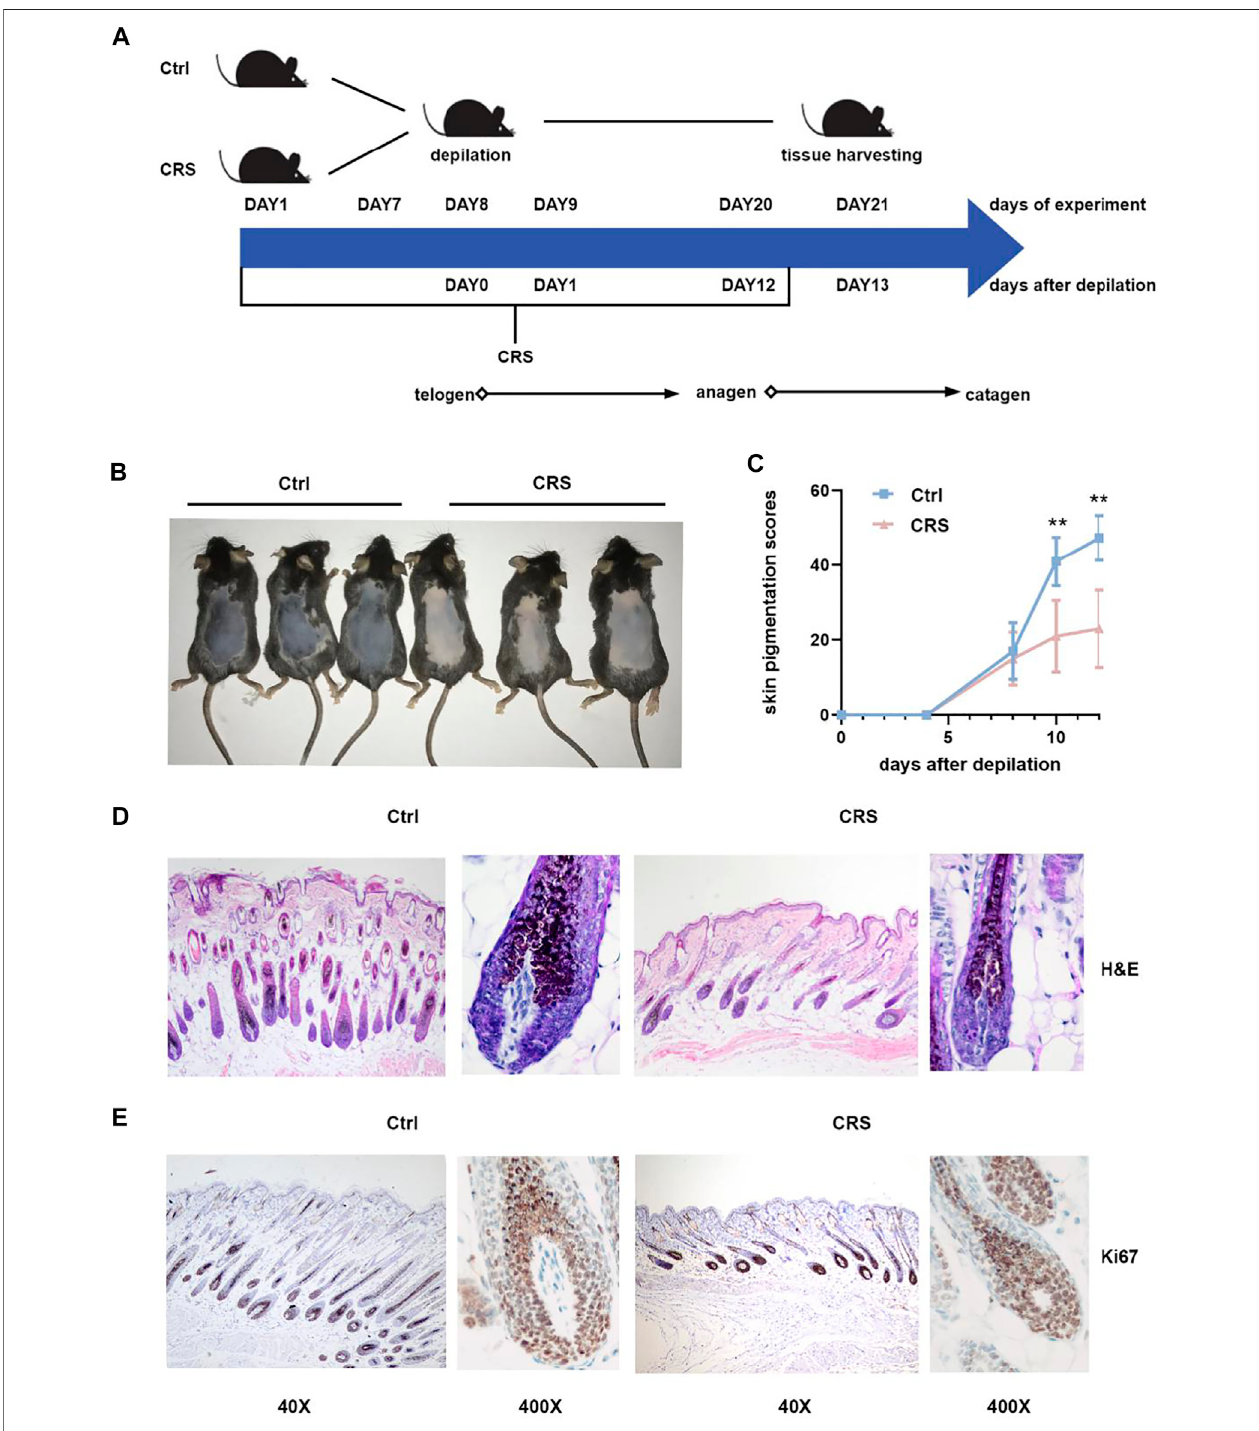
FIGURE 1 | CRS signi fi cantly suppresses hair growth. (A) Flow chart of the animal experiment. The CRS treatment was applied from day1 and lasted for 20 days. Thedepilationofmice wasonday8oftheexperiment, withoutapplyingCRS.Onday21oftheexperiment, allanimals weresacri fi cedforhistologicaland metabolomics and transcriptomics analysis. (B) Photograph shown was taken on day 21 of experiment in (A), by which time mice treated with CRS exhibited hair growth inhibition versus control. (C) Skin melanin pigmentation scores (described in Materials and Methods) of murine dorsal skins treated with CRS versus control. Data are representedasmean±SD.n=5miceineachgroup. p valuesaredeterminedbyStudent ’ st-test.** p < 0.01comparedwithcontrolgroup. (D) H&Estainingshowedthe morphological changes in hair follicle. Magni fi cation: 40×on the left; 400× on the right. (E) Immunohistochemistry for Ki-67 in back skin sections obtained from CRS group and control group. Magni fi cation: 40× on the left; 400× on the right.